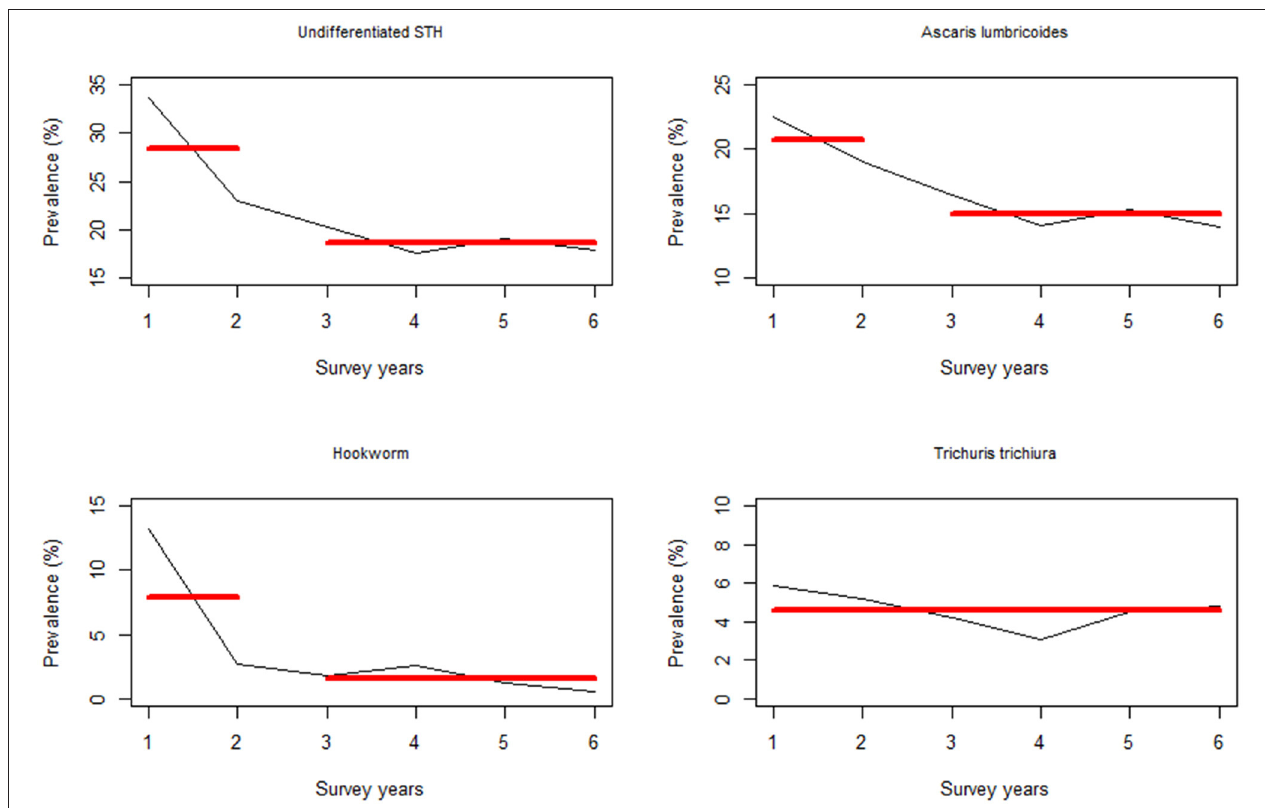
FIGURE 6 | Change point analysis using binary segmentation method for the pre-treatment prevalence (%) among the preschool aged (PSAC) group of children in Kenya.